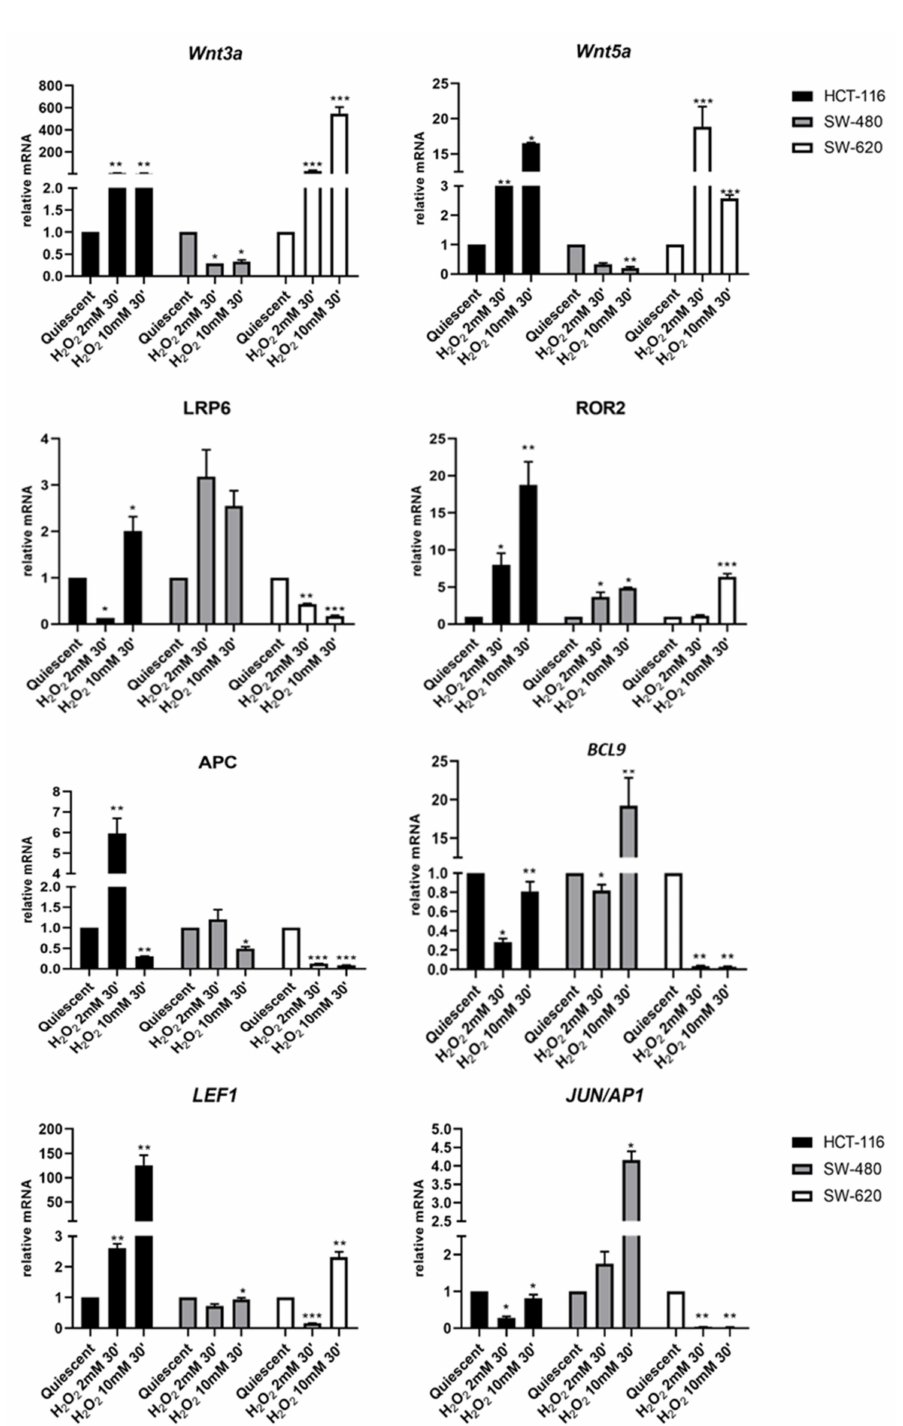
Figure 2. Expression of genes belonging to canonical and non-canonical Wnt signaling. Ligands: WNT3a , WNT5a ; Coreceptors: LRP6 and ROR2 ; β -Catenin controllers: APC and BCL9 gene expression modulation after 30 min of oxidative stress induced by H 2 O 2 2 mM and 10 mM in HCT116, SW480 and its metastatic cells SW620. Gene expression was analyzed by real Time-qPCR. The histogram represented normalized data with GUSB gene. The results showed the average of three independent experiments. * p < 0.05, ** p < 0.01, *** p < 0.001 treated vs. quiescent